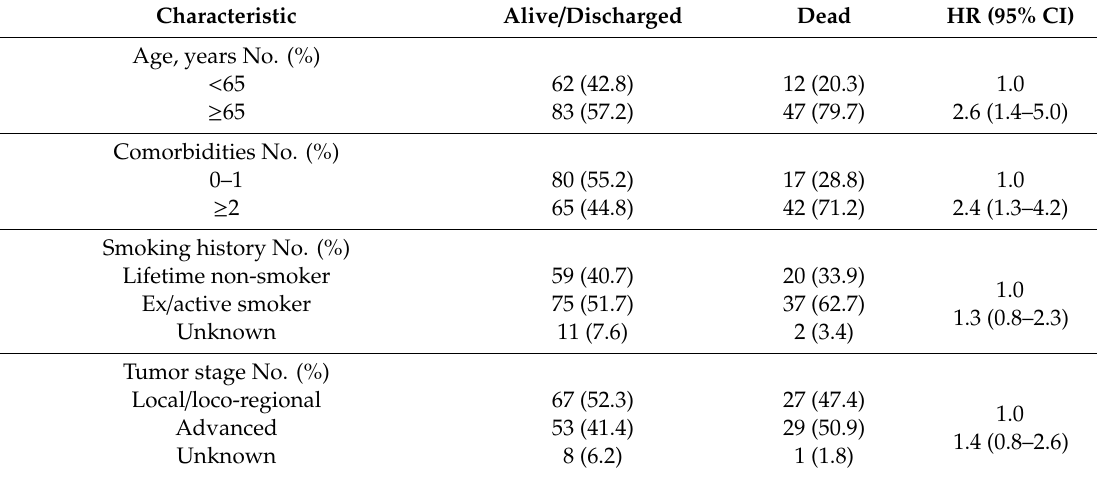
Figure 1. The relationship between mortality from COVID-19 and ( A ) baseline patient features and ( B ) complications from SARS-Cov-2 infection. * indicates p < 0.05. Table 3. The relationship between patient characteristics and mortality from COVID-19: univariable analysis .